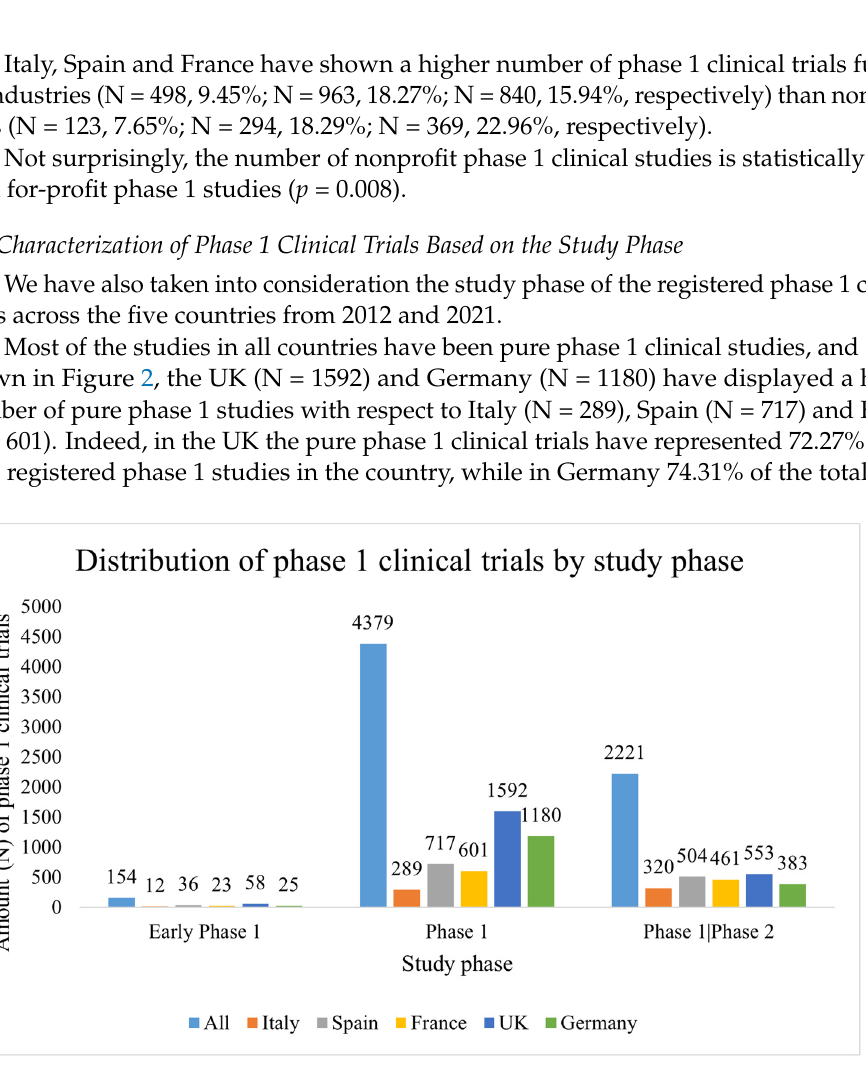
Figure 3. Distribution of phase 1 clinical trials by study design. The total number of registered phase 1 clinical trials on ClinicalTrials.gov was divided by country and study design. Five European countries were selected: France, Germany, Italy, Spain and the UK. The period from 1 January 2012 to 31 December 2021 was taken into consideration.